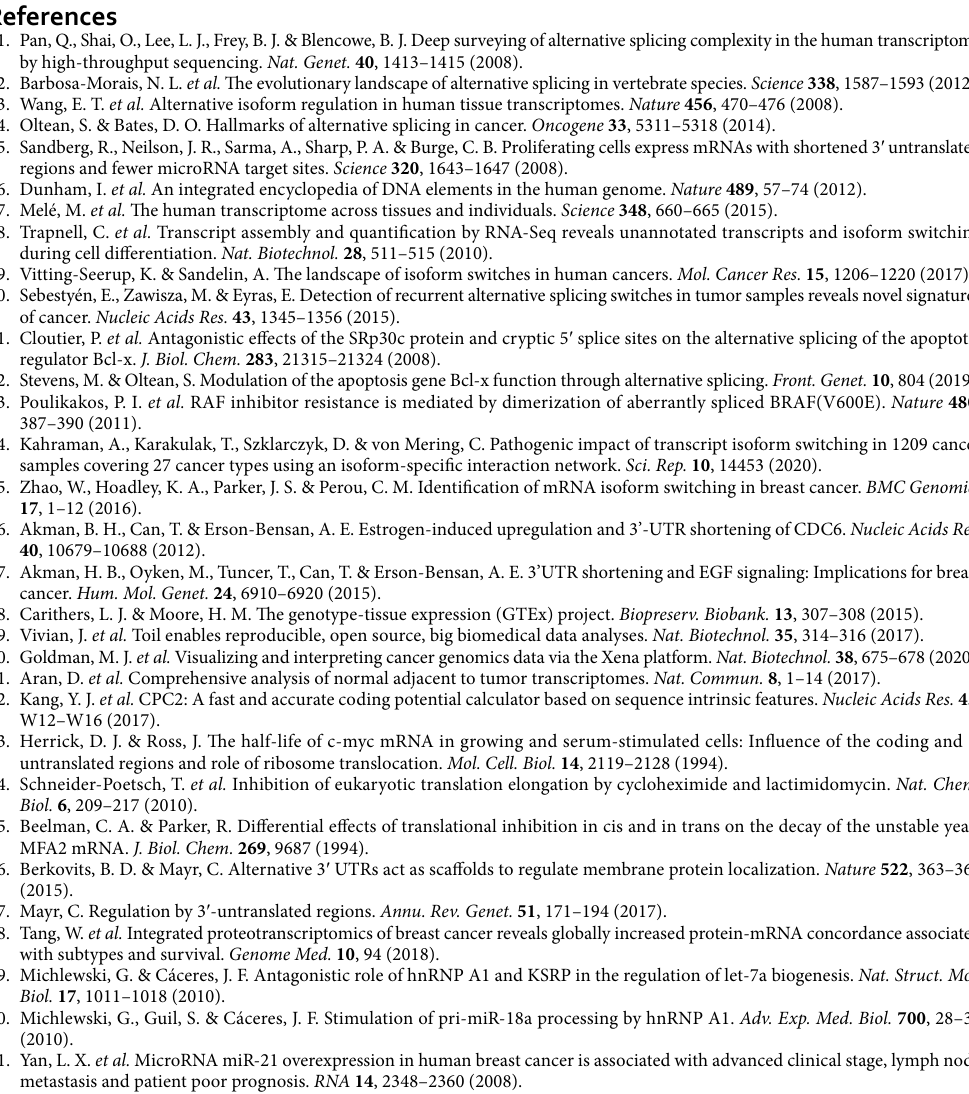
Figure 7. MiRNA levels in HNRNPA1 silenced cells. ( A ) miR-27b-3p count reads were decreased in HNRNPA1 silenced MDA-MB-231 cells on the NanoString miRNA panel. Mature miRNA levels in HNRNPA1 silenced MDA-MB-231 cells were detected by TaqMan miRNA PCR (n = 2 biological replicates), pri-miR-27b and host gene C9ORF3 expression levels were quantified by RT-qPCR (*p < 0.05, **p < 0.01, ****p < 0.0001; n = 3 biological replicates, one-way ANOVA, Tukey’s HSD). Gene structure of host gene, miR-27b, and primer positions are shown below the graphs. ( B ) miR-21 count reads were decreased in HNRNPA1 silenced MCF7 cells. Mature miRNA levels in HNRNPA1 silenced MCF7 cells were detected by TaqMan miRNA PCR, pri-miR-21, and host gene ( VMP1 ) expression levels were quantified by RT-qPCR. (*p < 0.05, **p < 0.01, ****p < 0.0001; n = 3, one-way ANOVA, Tukey’s HSD). Gene structure of host gene, miR-21 and primer positions are shown below the graphs. ( C ) Control and HNRNPA1 silenced MCF7 cells were transfected with miR-21 promoter-reporter and Renilla luciferase vector. Normalized luciferase activity is shown in HNRNPA1 silenced cells compared to controls (miRPP-21 is the canonical mir-21 promoter) (**p < 0.01 and ***p < 0.001 n = 3, one- way ANOVA, Tukey’s HSD). ( D ) miR21 sensor activity is low in control MCF7 cells compared to HNRNPA1 silenced cells (*p < 0.05, n = 3, one-way ANOVA, Tukey’s HSD). ( E ) High miR-21 expression correlates with poor overall survival in ER + breast cancer patients (TCGA) (from KM-plotter database) (logrank p = 0.044, HR = 1.76, FDR >